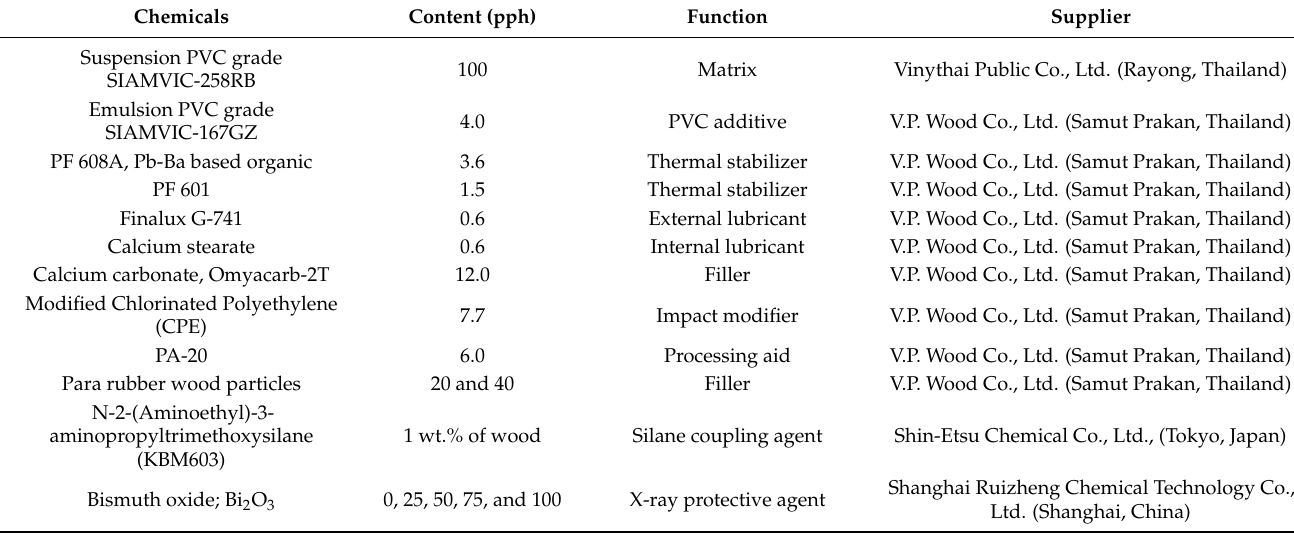
Table 1. Material formulations of WPVC composites and chemical names, contents, functions, and suppliers.